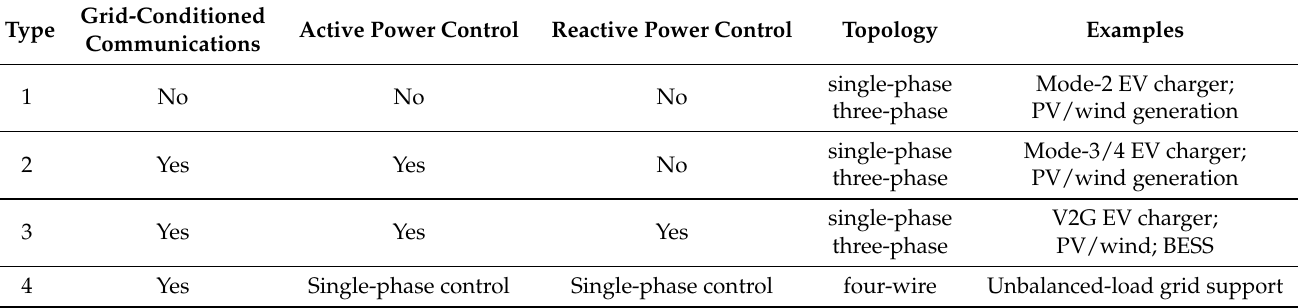
Table 1. Power converter